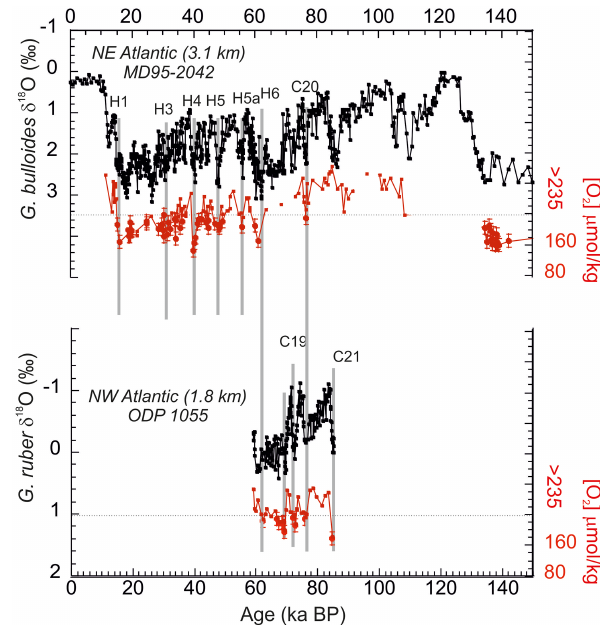
Figure 5. Reconstructed bottom water [O 2 ] at deep site MD95- 2042 and intermediate ODP Site 1055 shown with their planktonic foraminifera oxygen isotope records (Shackleton et al., 2000; Thor- nalley et al., 2013). Heinrich events 1, 3, 4, 5, 5a, and 6 and cold events 19, 20, and 21 are